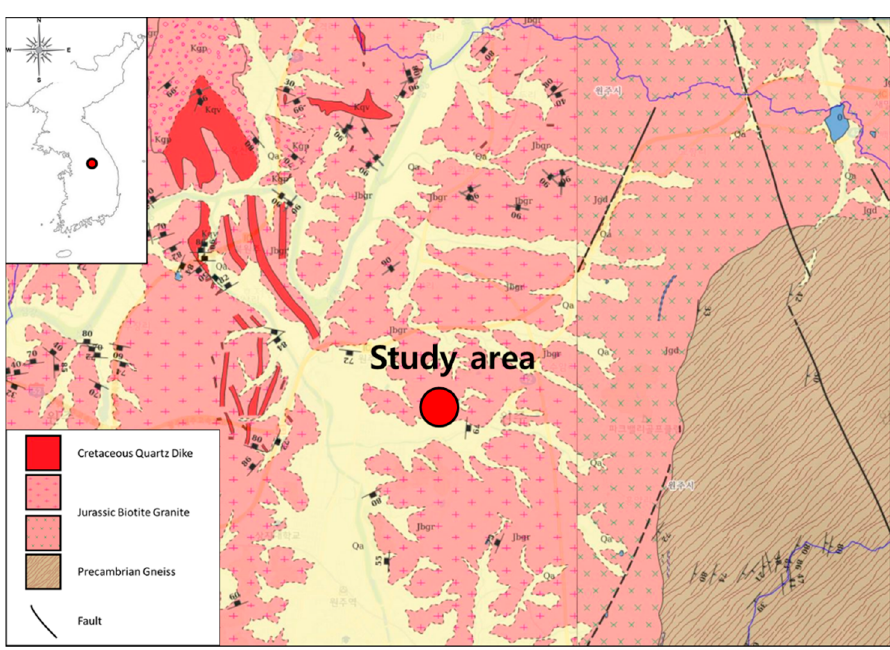
Figure 6. Geological map of the research area [10].